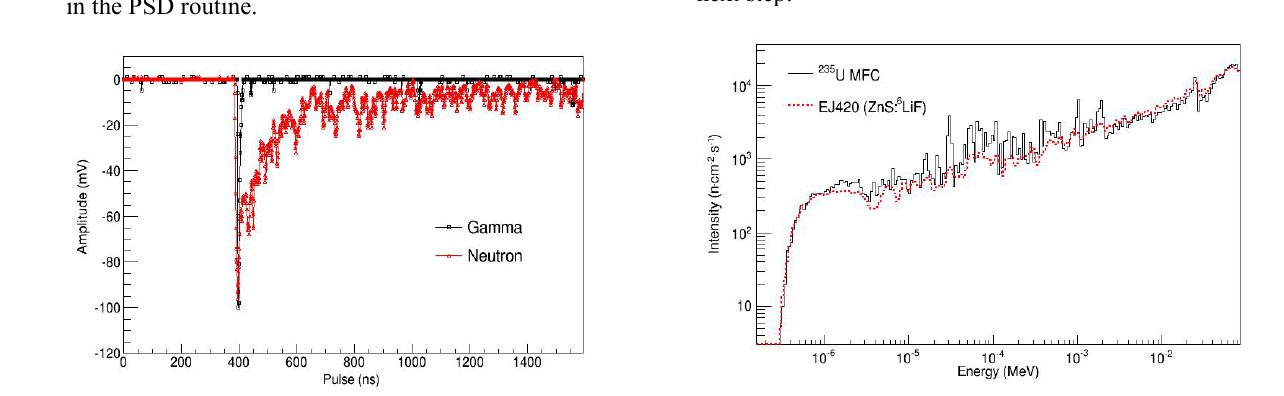
Fig.2 Waveforms of the EJ-420 detector: neutron waveform (red triangle) and gamma waveform (black square)